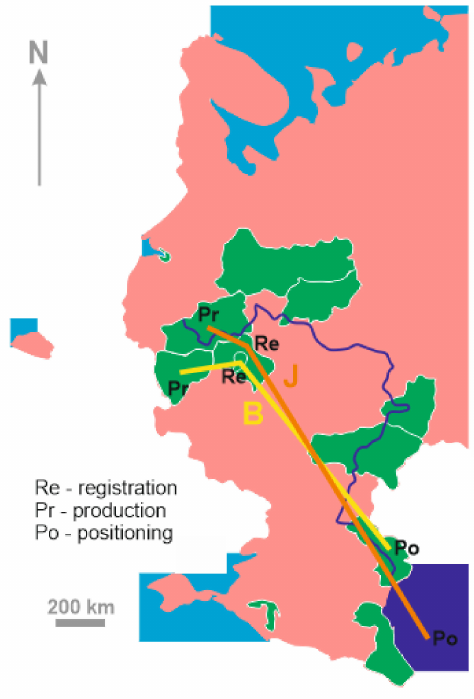
Figure 2. The most striking examples of the geographical dispersal of the Russian black caviar producers. The outline of Figure 1 is followed, and the explanations are given in the